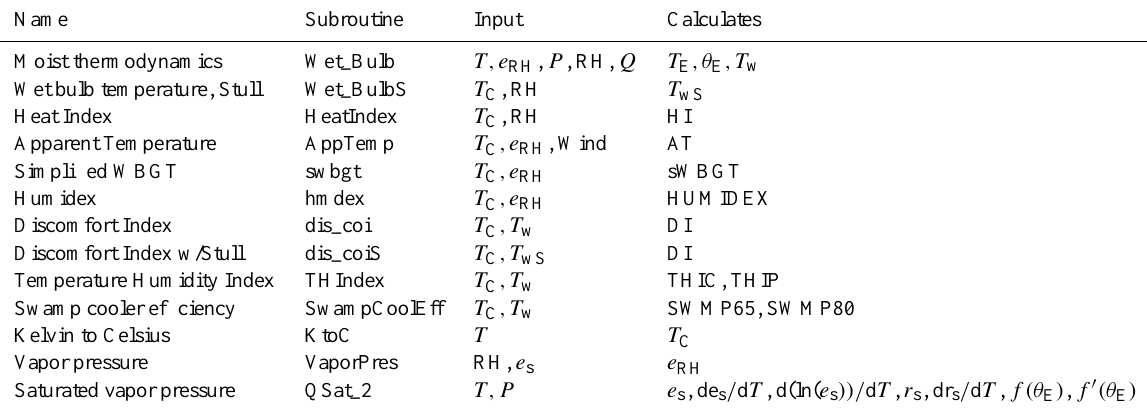
Table 4. The HumanIndexMod: subroutine names, required inputs, and variables